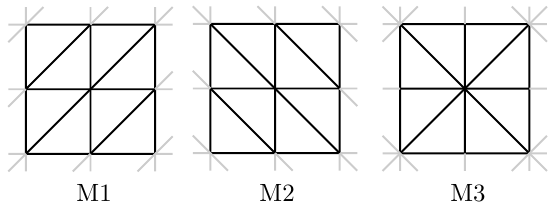
Figure 4. Three investigated